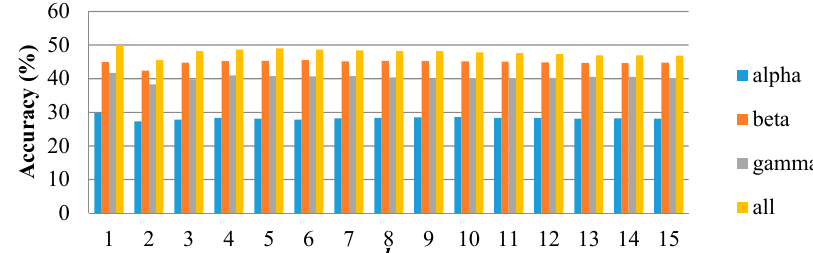
Figure 8. Average classification performance of bispectrum features by varying k values for the LBD group using k -nearest neighbor (KNN).